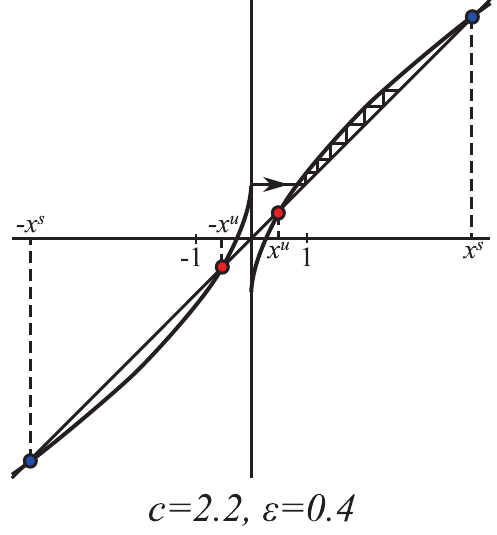
Fig. 6 The graph of T c , ε and the trajectory of the discontinuity point for c >